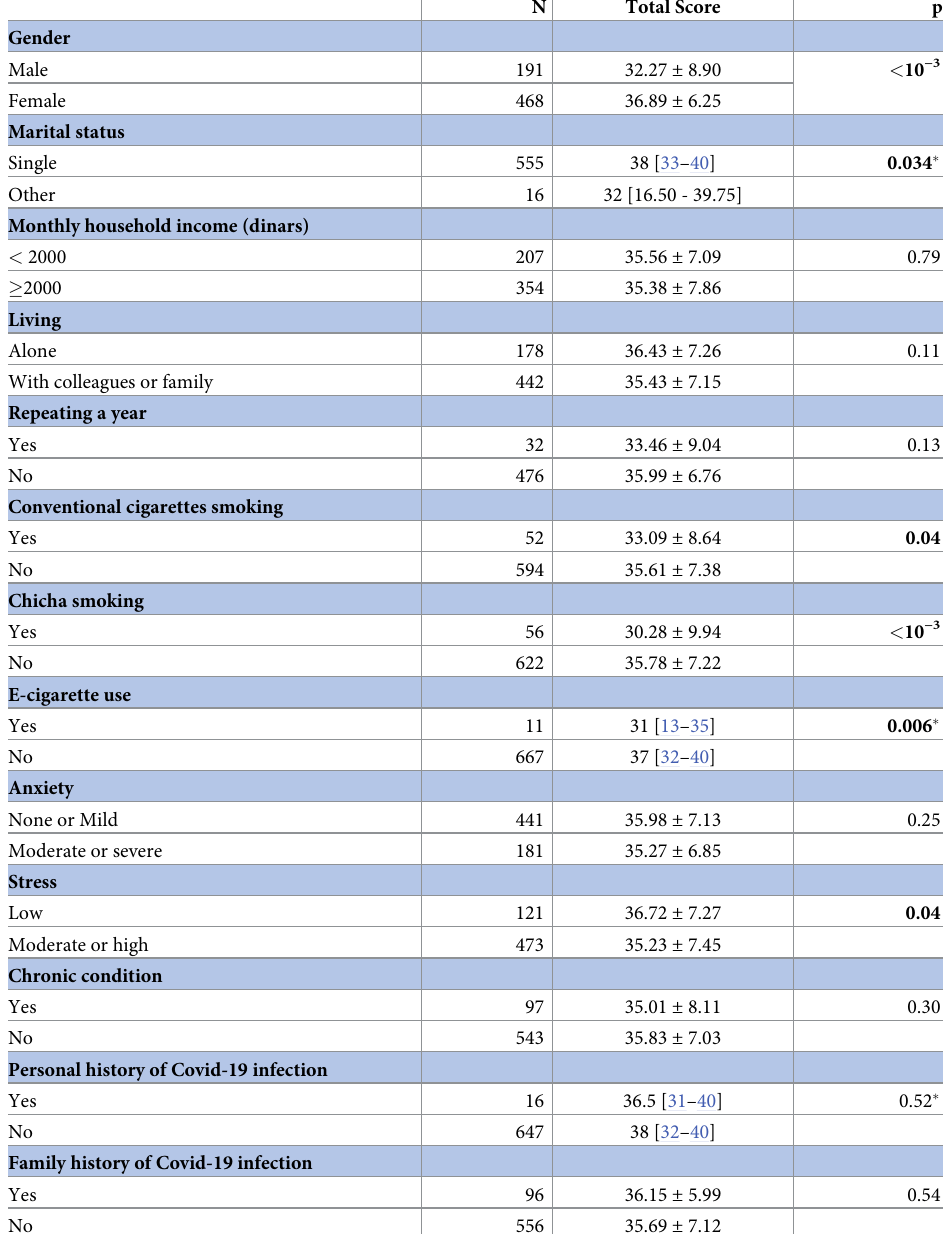
Table 3. The relationship between the study population characteristics and precautionary measures score.